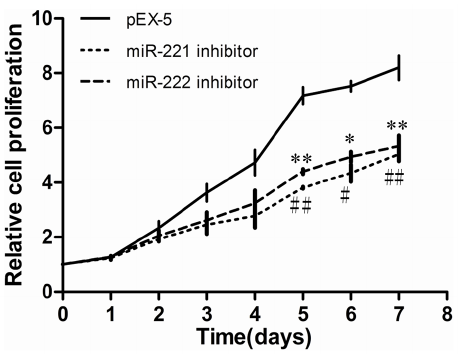
Figure 2. Effects of miR-221 inhibitor and miR-222 inhibitor on PC-3 cell proliferation. PC-3 cells were transfected with empty vector plasmid (pEX-5), miR-221 inhibitor, or miR-222 inhibitor. Cell prolifer- ation was analyzed using a CCK-8 assay. The proliferation of cells transfected with miR-221 inhibitor or miR-222 inhibitor was reduced compared with that transfected with pEX-5. Data represent the mean value 6 SEM from three separate experiments. *, # P , 0.05 vs pEX-5, **, ## P , 0.01 vs pEX-5.